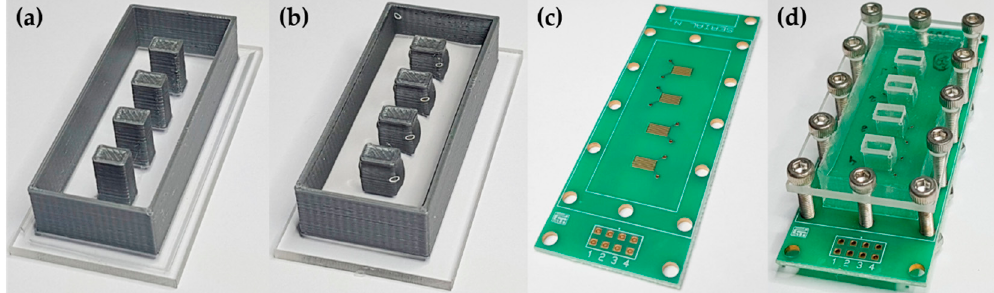
Figure 1. Development of the hollow structure to enable individual LbL deposition onto four collinear IDEs: ( a ) 3D-printed mold on an acrylic slide; ( b ) PDMS casting of the hollow structure; ( c ) PCB with the four collinear bare IDEs; ( d ) PDMS reversibly sealed on the PCB by mechanical pressure using screws and an acrylic plate.